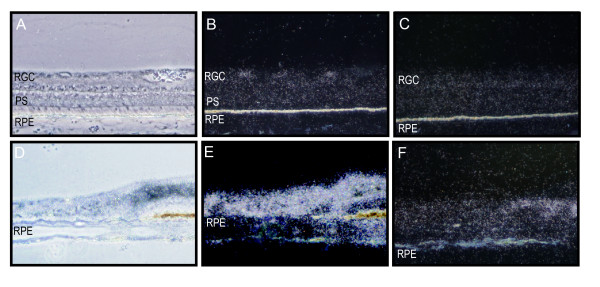
EpoR mRNA expression in the peripheral normal (A-C) and diabetic (D-F) retina. A, Phase contrast micrograph of the peripheral normal human retina. B, Anti-sense RNA probes for EpoR in normal retina demonstrates expression in the few retinal ganglion cells present in the peripheral retina. C, Control sense RNA probes for EpoR in normal retina. D, Phase contrast micrograph of a diabetic human retina shows loss of cytoarchitecture. E, Anti-sense RNA probes for EpoR shows intense signal in the peripheral retina. F, Control sense RNA probes for EpoR in diabetic retina. Abbreviations: RGC, retinal ganglion cell layer; INL, inner nuclear layer; ONL outer nuclear layer; RPE, retinal pigment epithelium layer; PS, photoreceptor segments.